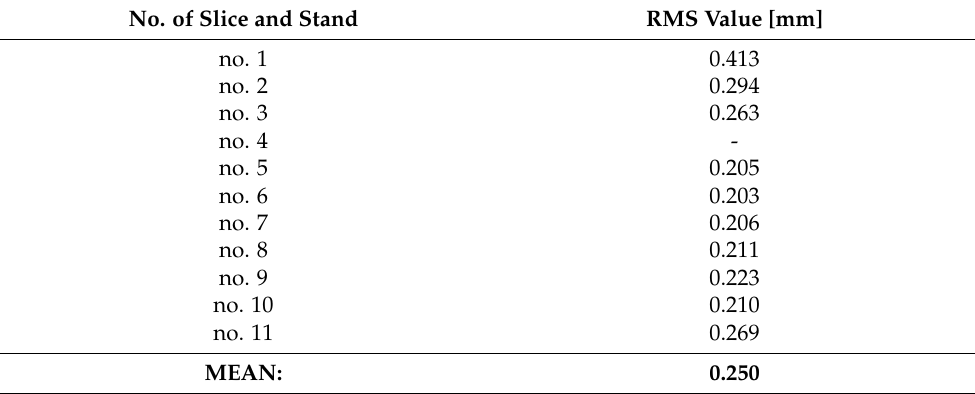
Table 2. The RMS value of registration for the stands.